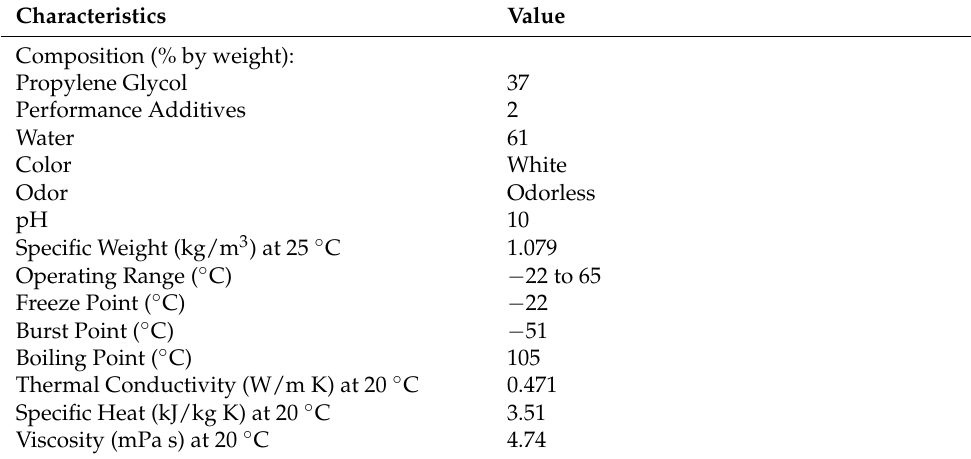
Table 2. Specifications of the